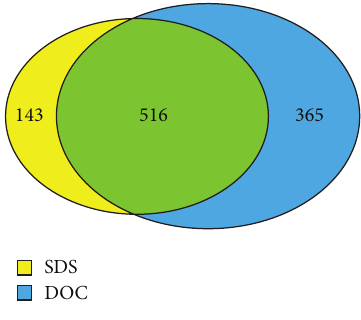
Figure 2: A comparison between the identified proteins from SDS- heat- and DOC-heat-extracted samples. A total of 1,024 unique proteins were identified from 1D shotgun